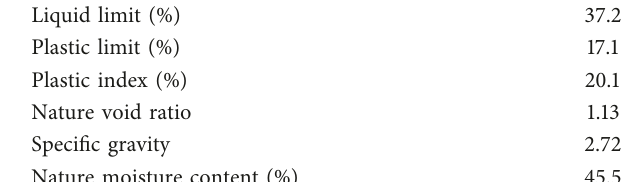
Figure 2: Particle-size distribution of scrap tire